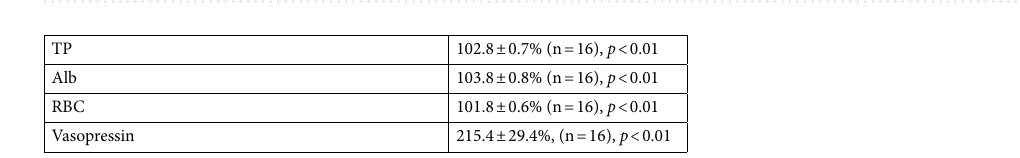
Figure 4. ( A ) Two representative recordings of exercise-induced sweating demonstrating simultaneously the timing points of informing the heatstroke risk (circle) and noticing the feeling thirst (level light+, level middle++, level severe+++). (a) ~ 40 years old female and (b) ~ 40 years old male. ( B ) The relationship between the informing point for heatstroke risk and the self-identification of thirst response in 12 participants. The abscissa shows each participant. The ordinate is the time difference between informing point of heatstroke risk (zero) and self-identification thirst response. The rest 4 participants did not identify the thirst response during the 30 min physical exercise.